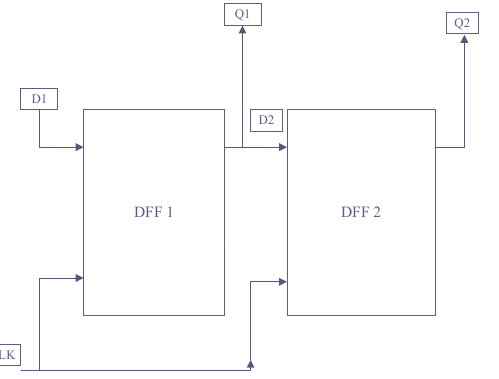
Figure 10. Block diagram presentation of 2-bit PIPO shift register.